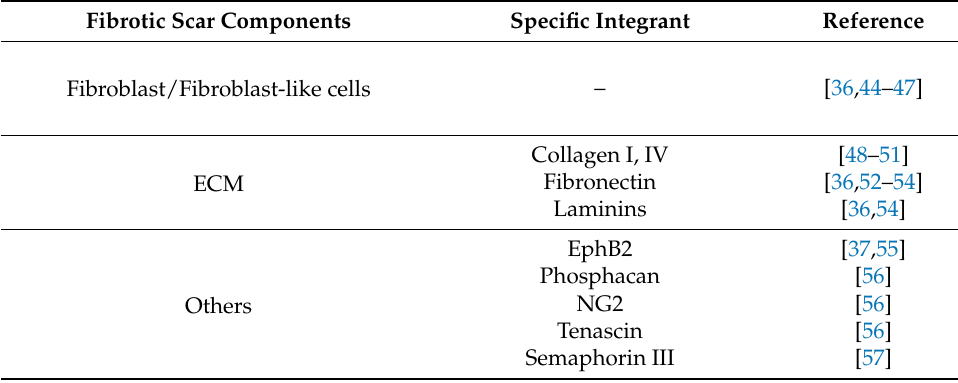
Fibrotic Scar Components Specific Integrant Reference Fibroblast/Fibroblast-like cells